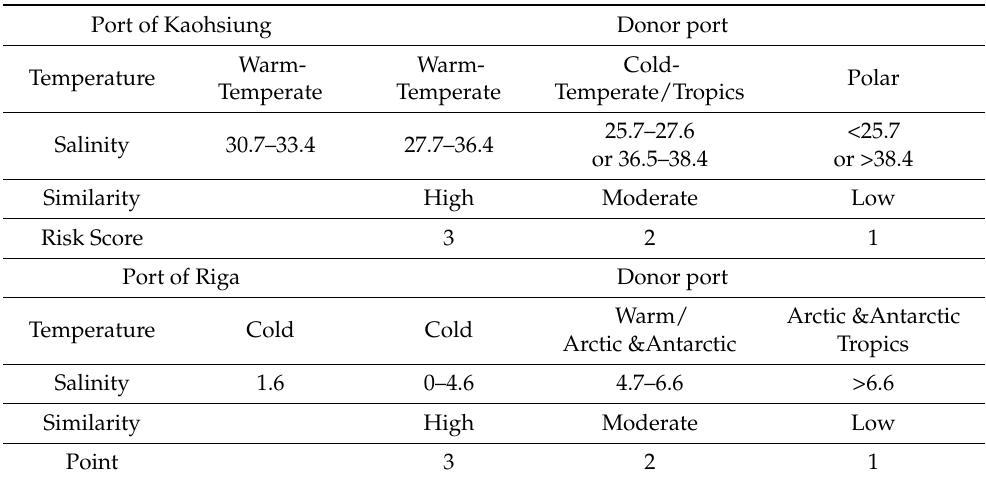
Table 1. Evaluation criteria for the environmental match of the donor port and the port of Kaohsiung and